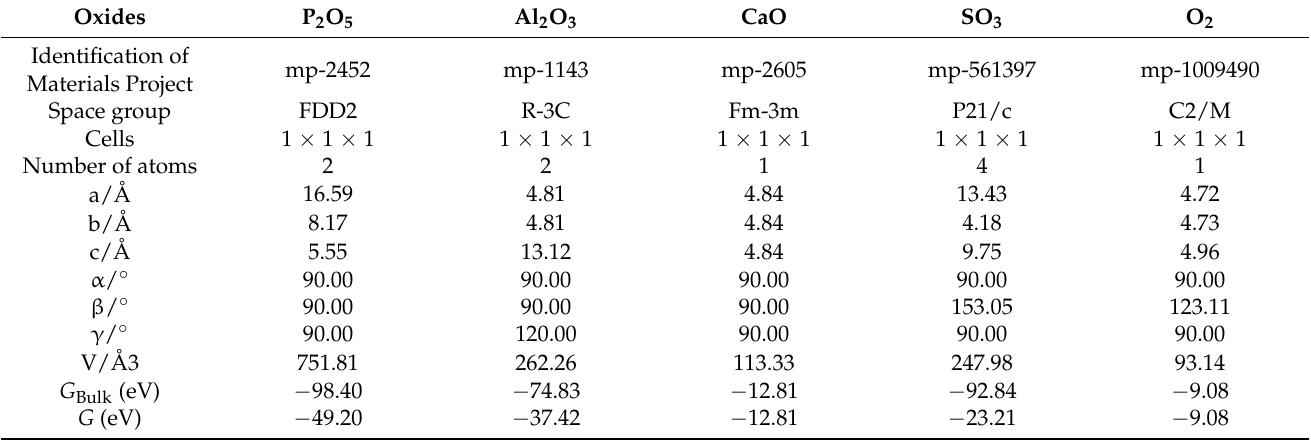
Table A2. Details on Gibbs free energies involved in calculations for µ P and µ 0